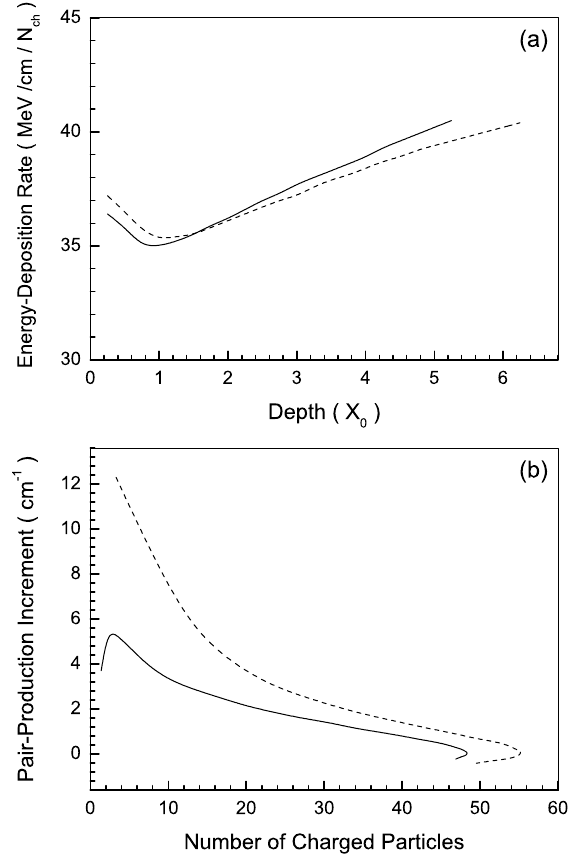
FIG. 2. Energy deposition rate per charged particle (a) and the logarithmic increment (b) in tungsten targets at E 10 GeV . Solid lines are for amorphous and dashed lines for crystal